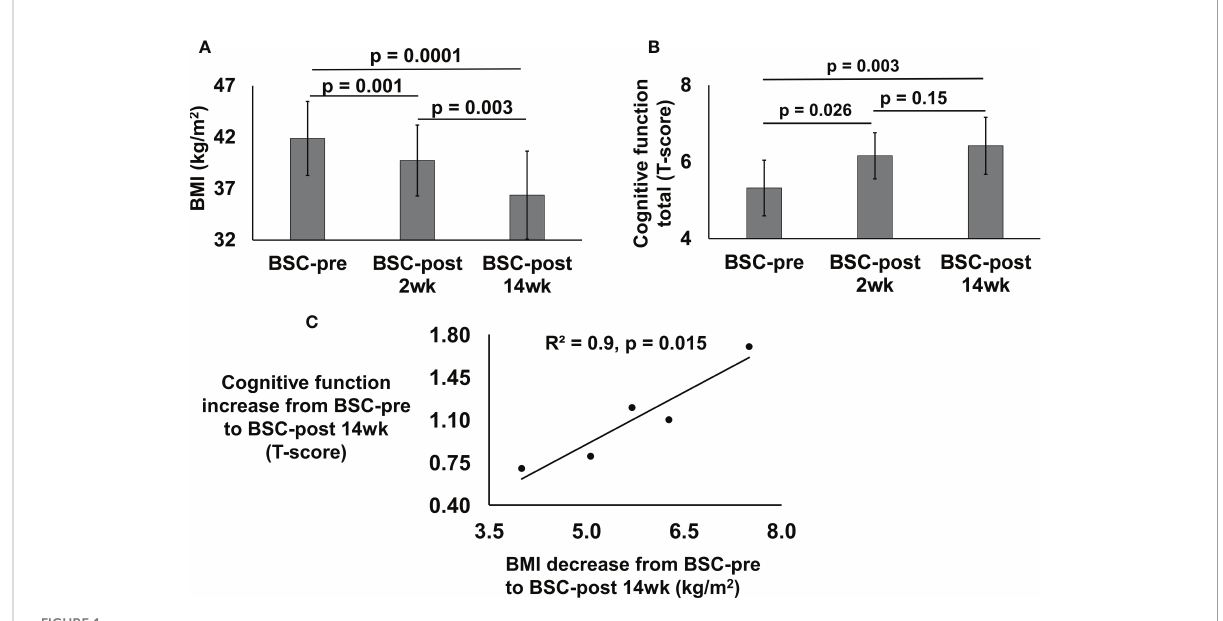
FIGURE 1 BMI (kg/m2) (A) and cognitive function total (T-score) (B) of the bariatric surgery candidates (BSC) group with severe/class 3 obesity before (BSC-pre), two weeks after (BSC-post 2wk), and fourteen weeks after (BSC-post 14wk) surgery. BMI data was assessed for 6 participants; cognitive function was assessed for 5 participants. Cross correlation between the BMI decrease from BSC-pre to BSC-post 14wk and cognitive function increase from BSC-pre to BSC-post 14 wk (C) , p =